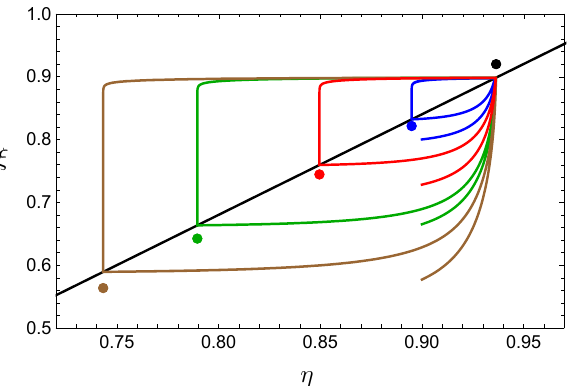
Figure 10. The maximum ice sheet size increases as D G decreases. Blue : D G = 0.385. Red : D G = 0.36. Green : D G = 0.3. Brown : D G =